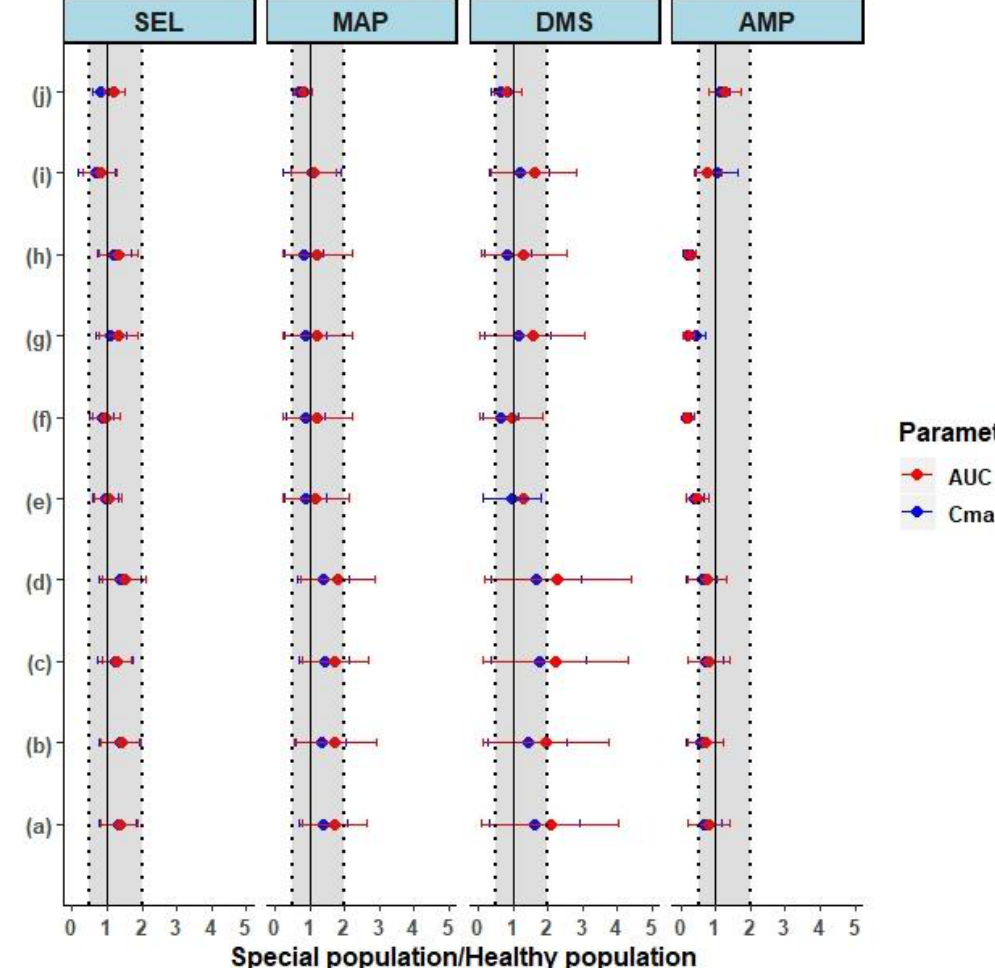
Figure 6. The forest plot shows the mean ± SD predicted in special populations over the predicted healthy ratio of pharmacokinetic parameters in healthy subjects. The dotted and shaded area represents the 0.5- to 2-fold range and the solid black line represents the line of unity. The compounds SEL: Selegiline, MAP: Methamphetamine, DMS: Desmethyl Selegiline, and AMP: Amphetamine are shown as faceted plots. ( a ) Single dose Transdermal pharmacokinetics in moderate renally impaired subjects versus healthy adults at 20 mg / 20 cm 2 for 24 h; ( b ) single dose Transdermal pharmacokinetics in severe renally impaired subjects versus healthy adults at 20 mg / 20 cm 2 for 24 h; ( c ) single dose Transdermal pharmacokinetics in moderate renally impaired subjects versus healthy adults with unbound pharmacokinetic parameters at 20 mg / 20 cm 2 for 24 h, ( d ) single dose Transdermal pharmacokinetics in severe renally impaired subjects versus healthy adults with unbound pharmacokinetic parameters at 20 mg / 20 cm 2 for 24 h; ( e ) single dose Transdermal pharmacokinetics in moderate Child-Pugh-B hepatic impaired subjects versus healthy adults at 20 mg / 20 cm 2 for 24 h; ( f ) single dose Transdermal pharmacokinetics in severe Child-Pugh-C hepatic impaired subjects versus healthy at 20 mg / 20 cm 2 for 24 h; ( g ) single dose Transdermal pharmacokinetics in moderate Child-Pugh-B hepatic impaired subjects versus healthy adults with unbound pharmacokinetic parameters at 20 mg / 20 cm 2 for 24 h; ( h ) single dose Transdermal pharmacokinetics in severe Child-Pugh-C hepatic impaired subjects versus healthy adults with unbound pharmacokinetic parameters at 20 mg / 20 cm 2 for 24 h; ( i ) single dose Transdermal pharmacokinetics in adolescent subjects versus healthy adults at 20 mg / 20 cm 2 for 24 h; ( j ) multiple dose Transdermal pharmacokinetics in adolescents versus adult subjects at 20 mg / 20 cm 2 / 24 h for 10